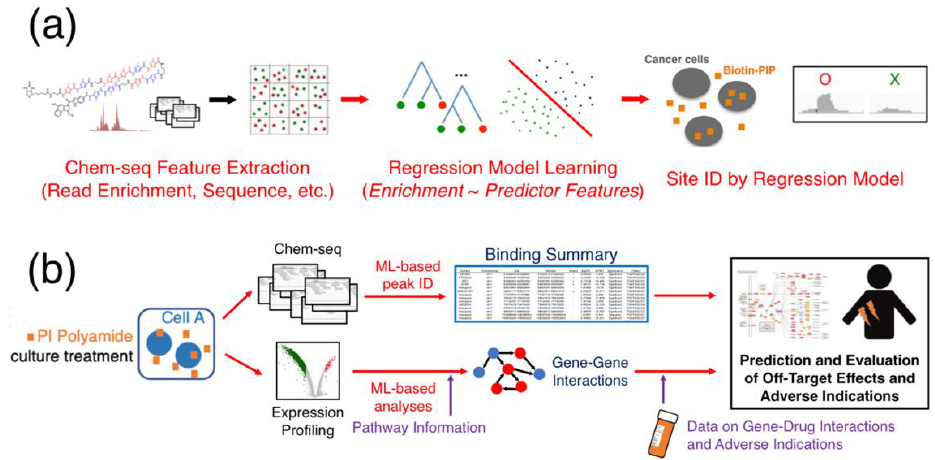
Figure 6. The use of machine learning to improve PIP off-target analysis from high-throughput data. ( a ) A proposal for using machine-learning methods to improve the site identification process in Chem-seq post-sequencing analysis. ( b ) A scheme of incorporating machine learning (ML) in characterizing genomic binding, as well as expression profiling data, to generate genetic interactions to elucidate the role of off-target effects for candidate PIPs.